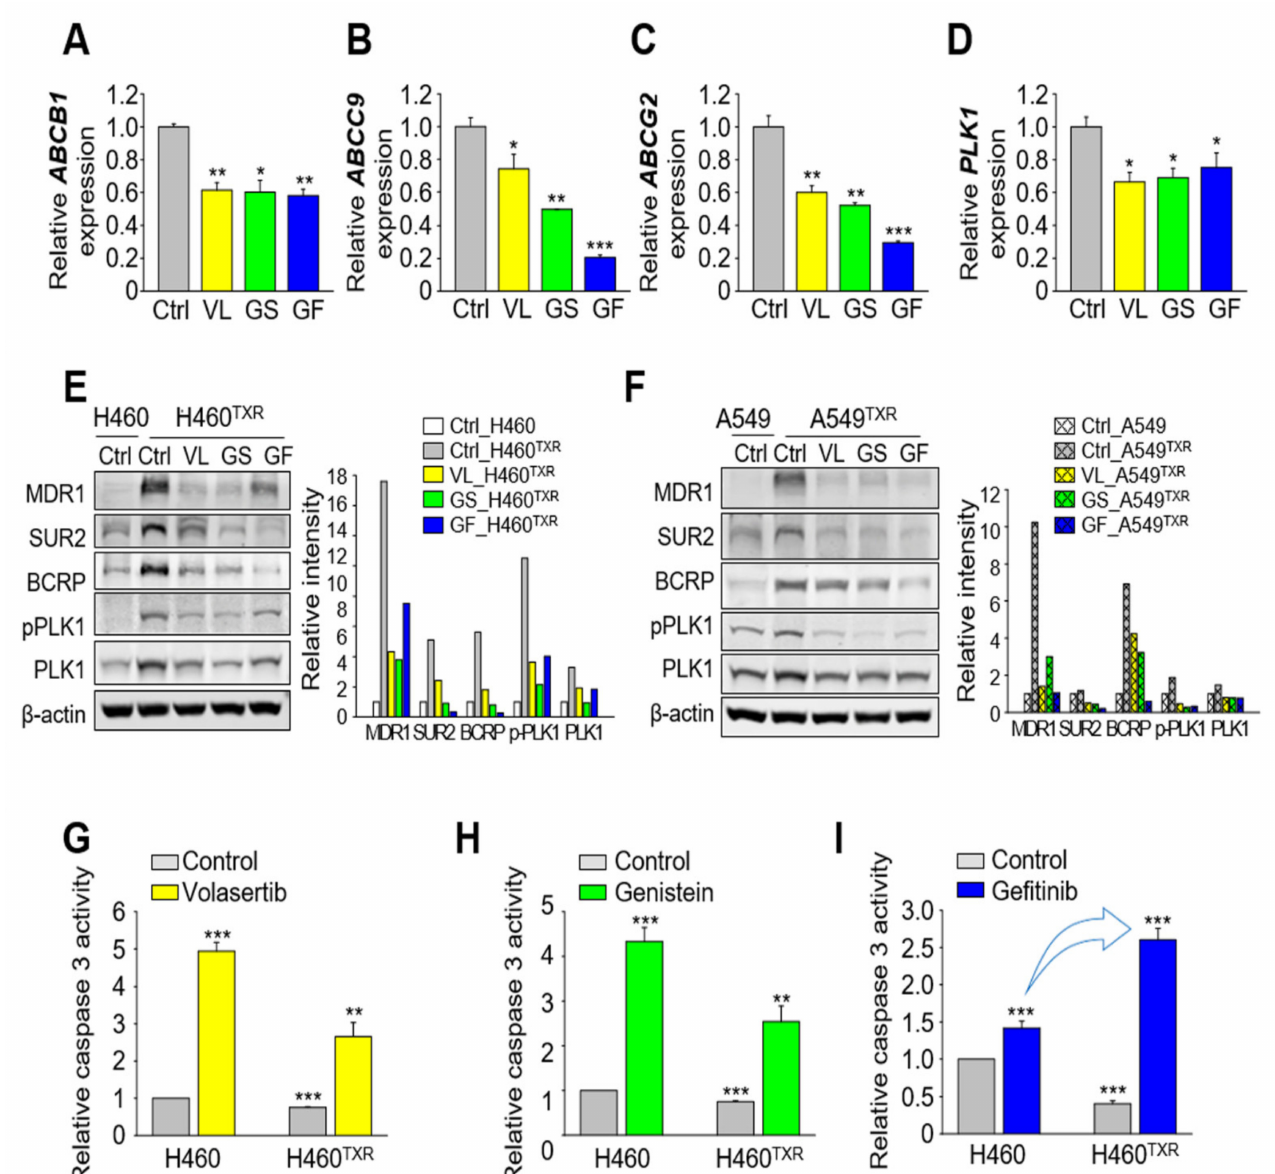
Figure 4. Gefitinib induces apoptosis more effectively in paclitaxel-resistant lung cancer cells expressing high mRNA levels of EGFR , PLK1 , and ABCB1 than in non-resistant lung cancer. ( A – F ) NCI-H460 TXR ( A – E ) or A549 TXR ( F ) cells were grown for 48 h in the presence of volasertib, genistein, or gefitinib at the concentration of GI 60 of each reagent in NCI-H460 TXR cells. Quantitative RT-PCR was performed to evaluate the mRNA levels of ( A ) ABCB1 , ( B ) ABCC9 , ( C ) ABCG2 , and ( D ) PLK1 in parental (H460) and paclitaxel-resistant NCI-H460 (H460 TXR ) cells. Three independent experiments were performed. The relative expression levels of mRNA were plotted. *, p < 0.05; **, p < 0.01; ***, p < 0.001 compared with control. ( E , F ) Cell lysates were subjected to immunoblotting with anti-MDR1 (ABCB1), anti-SUR2 (ABCC9), anti-BCRP (ABCG2), anti-PLK1, and anti- β − actin antibodies. The relative intensities were quantified using LI-COR Odyssey software (Li-COR Biosciences), normalized, and plotted. (G-I) H460 TXR cells were grown for 48 h in the presence of ( G ) volasertib, ( H ) genistein, or ( I ) gefitinib at the concentration of GI 60 of each reagent in H460 TXR cells. Cell lysates were subjected to a fluorometric caspase 3 activity assay. The means ± SEMs (error bars) of data from at least three experiments are shown. *, p < 0.05; **, p < 0.01; ***, p < 0.001 compared with control of H460